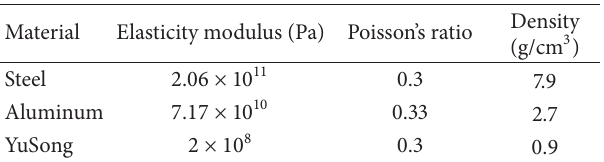
Table 2: The physical parameters of